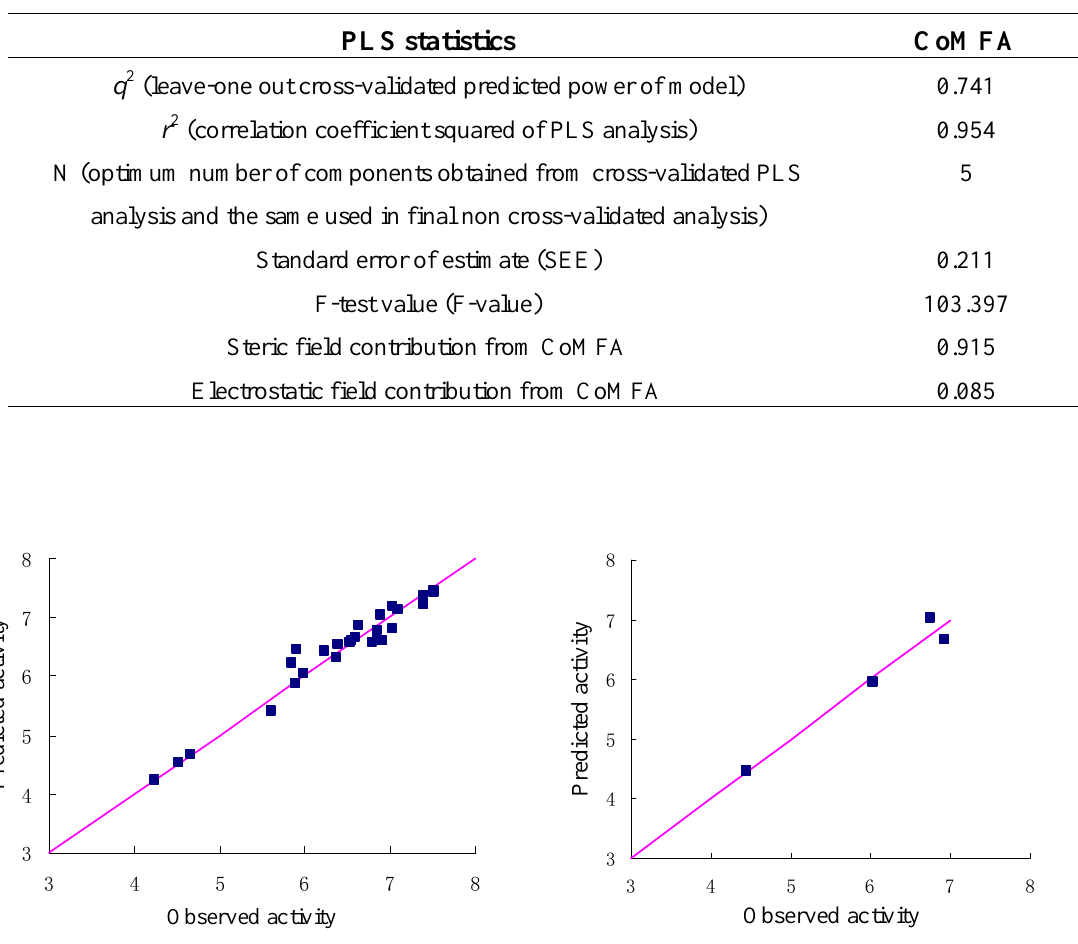
Table 3. PLS statistics of CoMFA 3D-QSAR model.